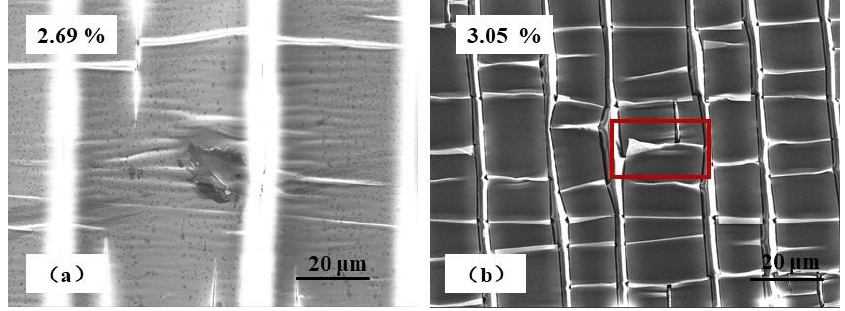
Figure 5. Buckling and fracture of 50 nm ITO film on PC. ( b ) was an enlarged drawing of ( a ).